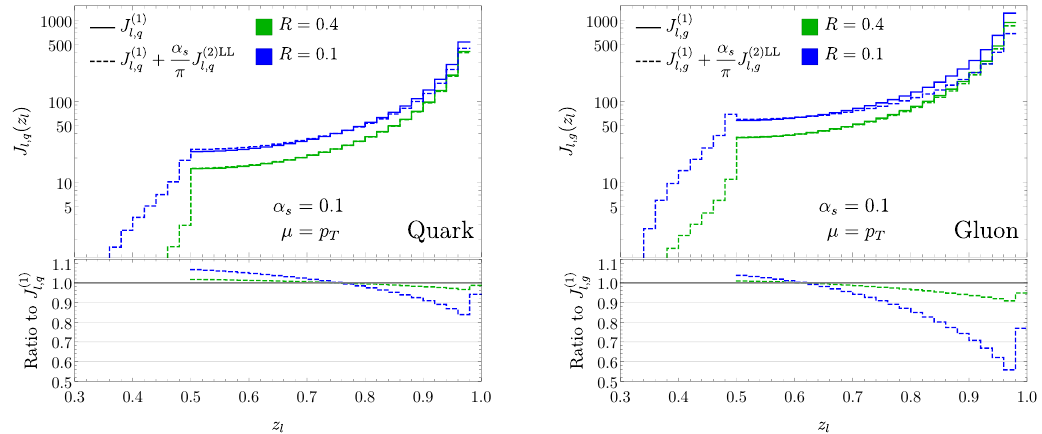
Figure 3 . Comparison between the NLO without (solid lines) and with the NNLO LL correction (dashed lines) to the quark (left) and gluon (right) leading-jet functions for R = 0 : 4 (green lines) and R = 0 : 1 (blue lines). The LL terms at NNLO are added to the NLO with the appropriate prefactor ( (cid:11) s =(cid:25) ), see eq.